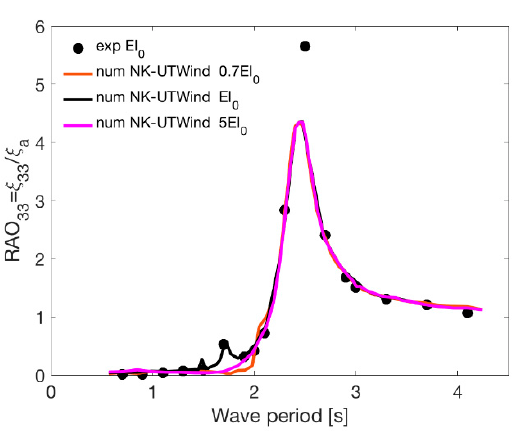
Figure 18. RAO heave motion result comparisons between the experiment and NK-UTWind nu- merical calculations for different structural rigidities.